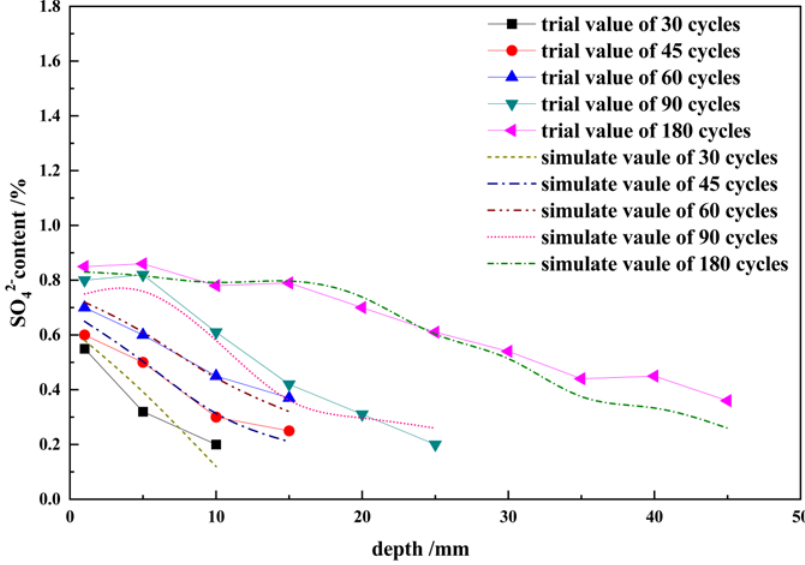
Figure 7. Comparison of calculated and experimental results.